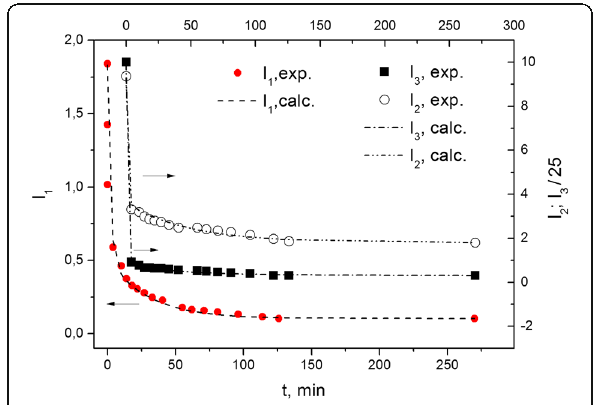
Fig. 4 The decline of the intensity of the EPR spectrum components L L L 1 , 2 , and 3 after the contact of the sample with the air. Start time t = 0 corresponds to the condition of the Fig. 3